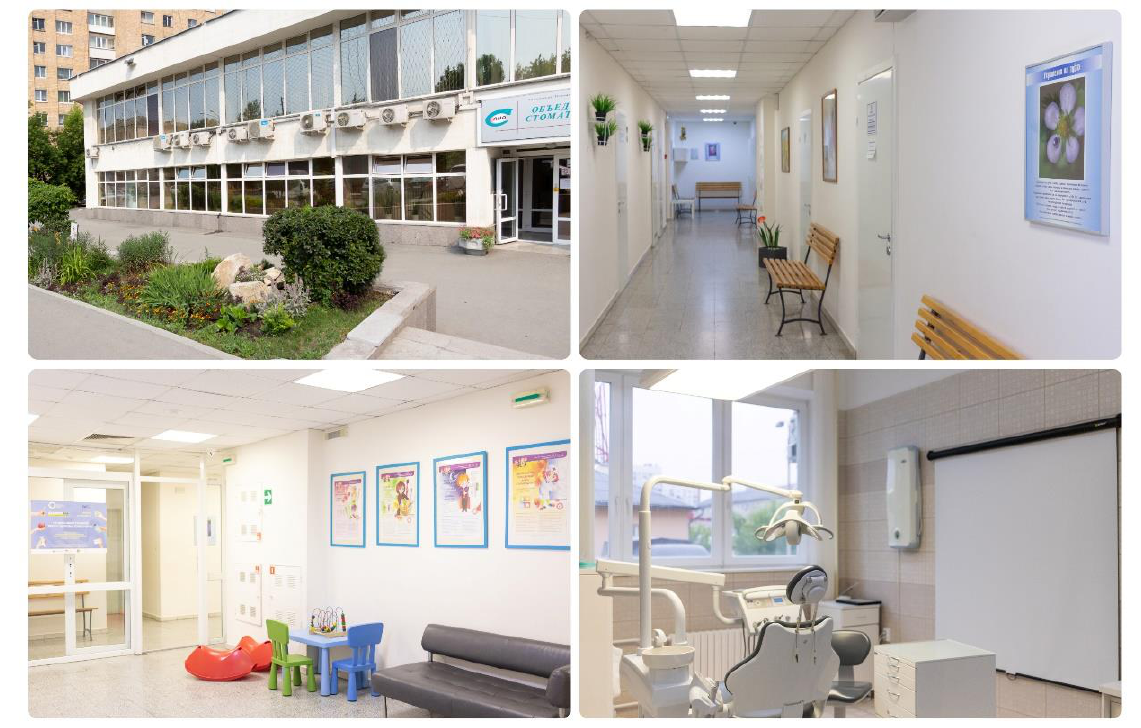
Figure 2. Environment of the government dental clinic.